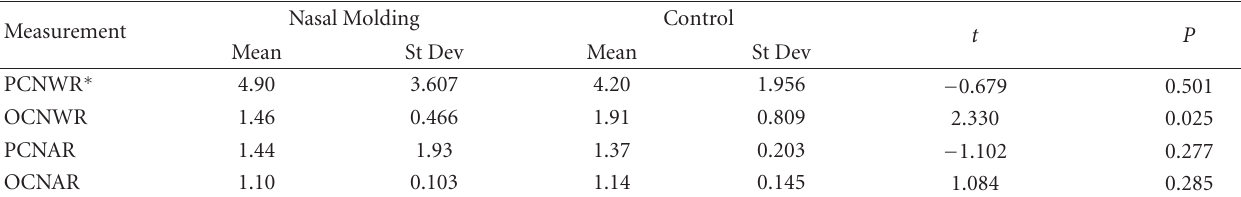
Table 1: Comparison of ratio means between